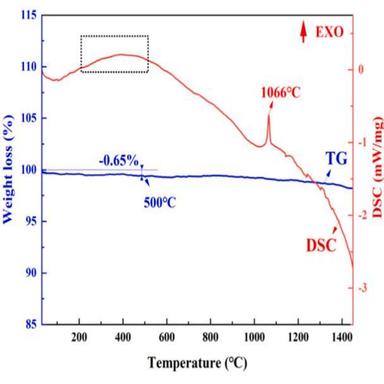
TG-DSC analysis of the agglomerated powders (Lu2O3 + SiO2).